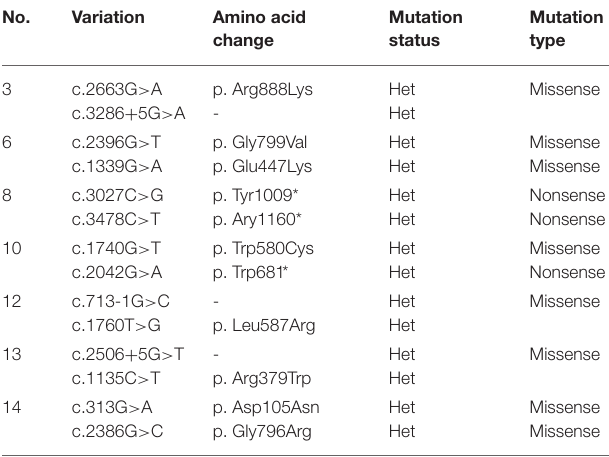
TABLE 3 | Variant locus analysis in patients with NPHS1 mutation. No. Variation Amino acid